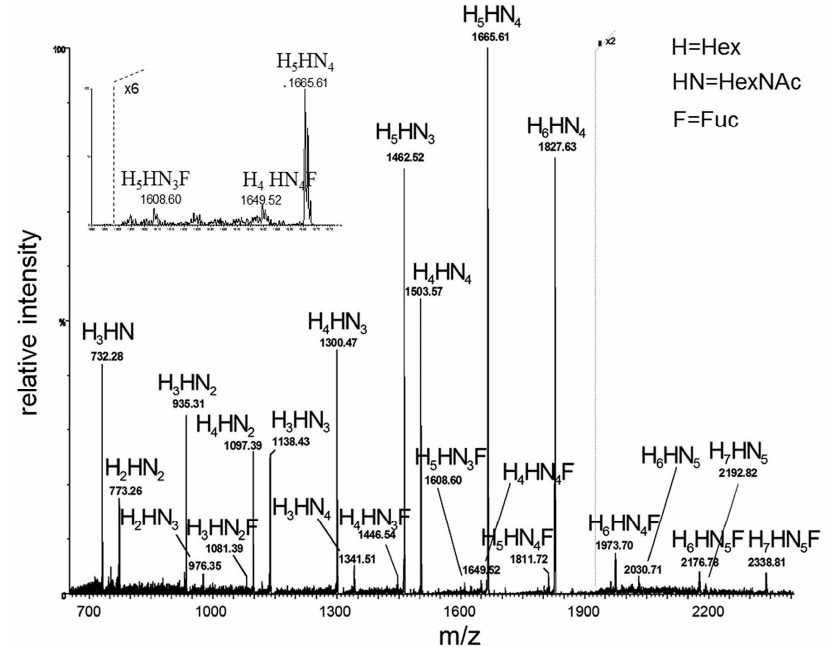
Figure 8. (+) MALDI-TOF spectrum of a chromatographic fraction containing human milk oligosaccharide alditols. The m / z values represent [M + Na] + ions. Reproduced from [49]. Copyright MDPI, 2014.